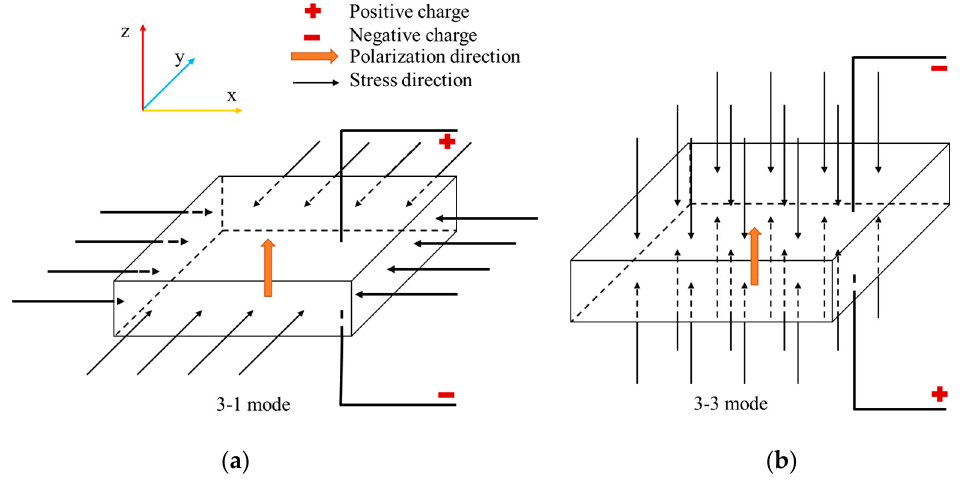
Figure 1. Working modes of the piezoelectric energy harvester (PEH): ( a ) 3-1 mode; ( b ) 3-3 mode.